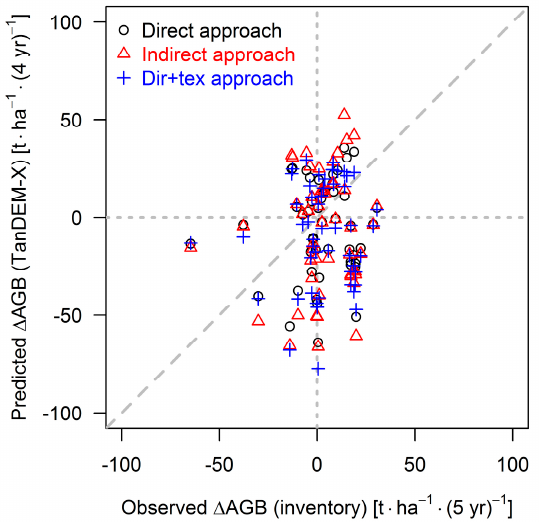
Figure 7. TanDEM-X-derived distributions of ( a , b ) mean top-of-canopy height (TCH10); ( c ) height change ( Δ TCH10) and ( d ) inventory-derived biomass change at 1 ha scale within the 4-year interval. Table 1. R 2 values for the 1:1 relationships of Δ AGB predictions from TanDEM-X data following the three different approaches vs. inventory-based Δ AGB and against each other.